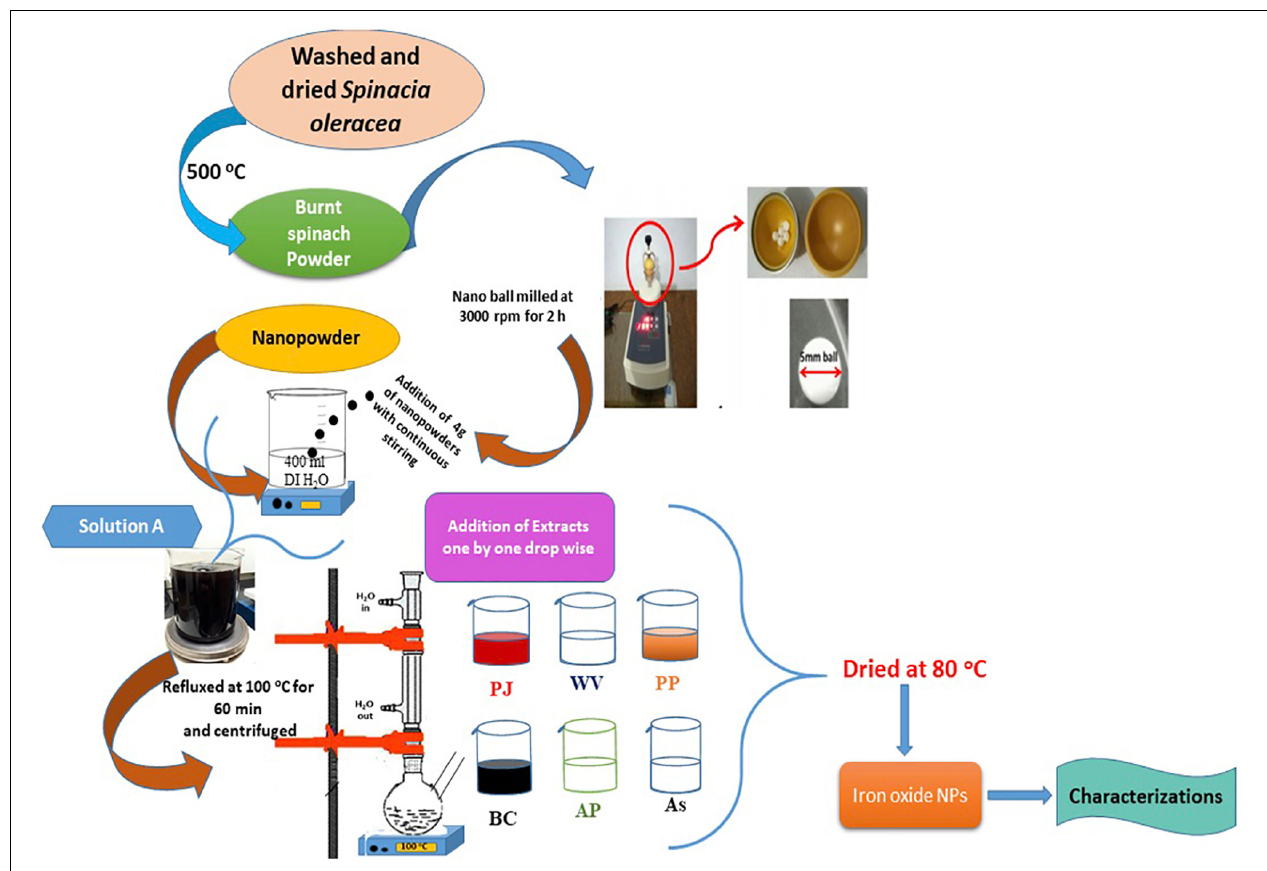
FIGURE 1 | Schematic showing the green synthesis of iron oxide nanoparticles (IONPs) using spinach and various